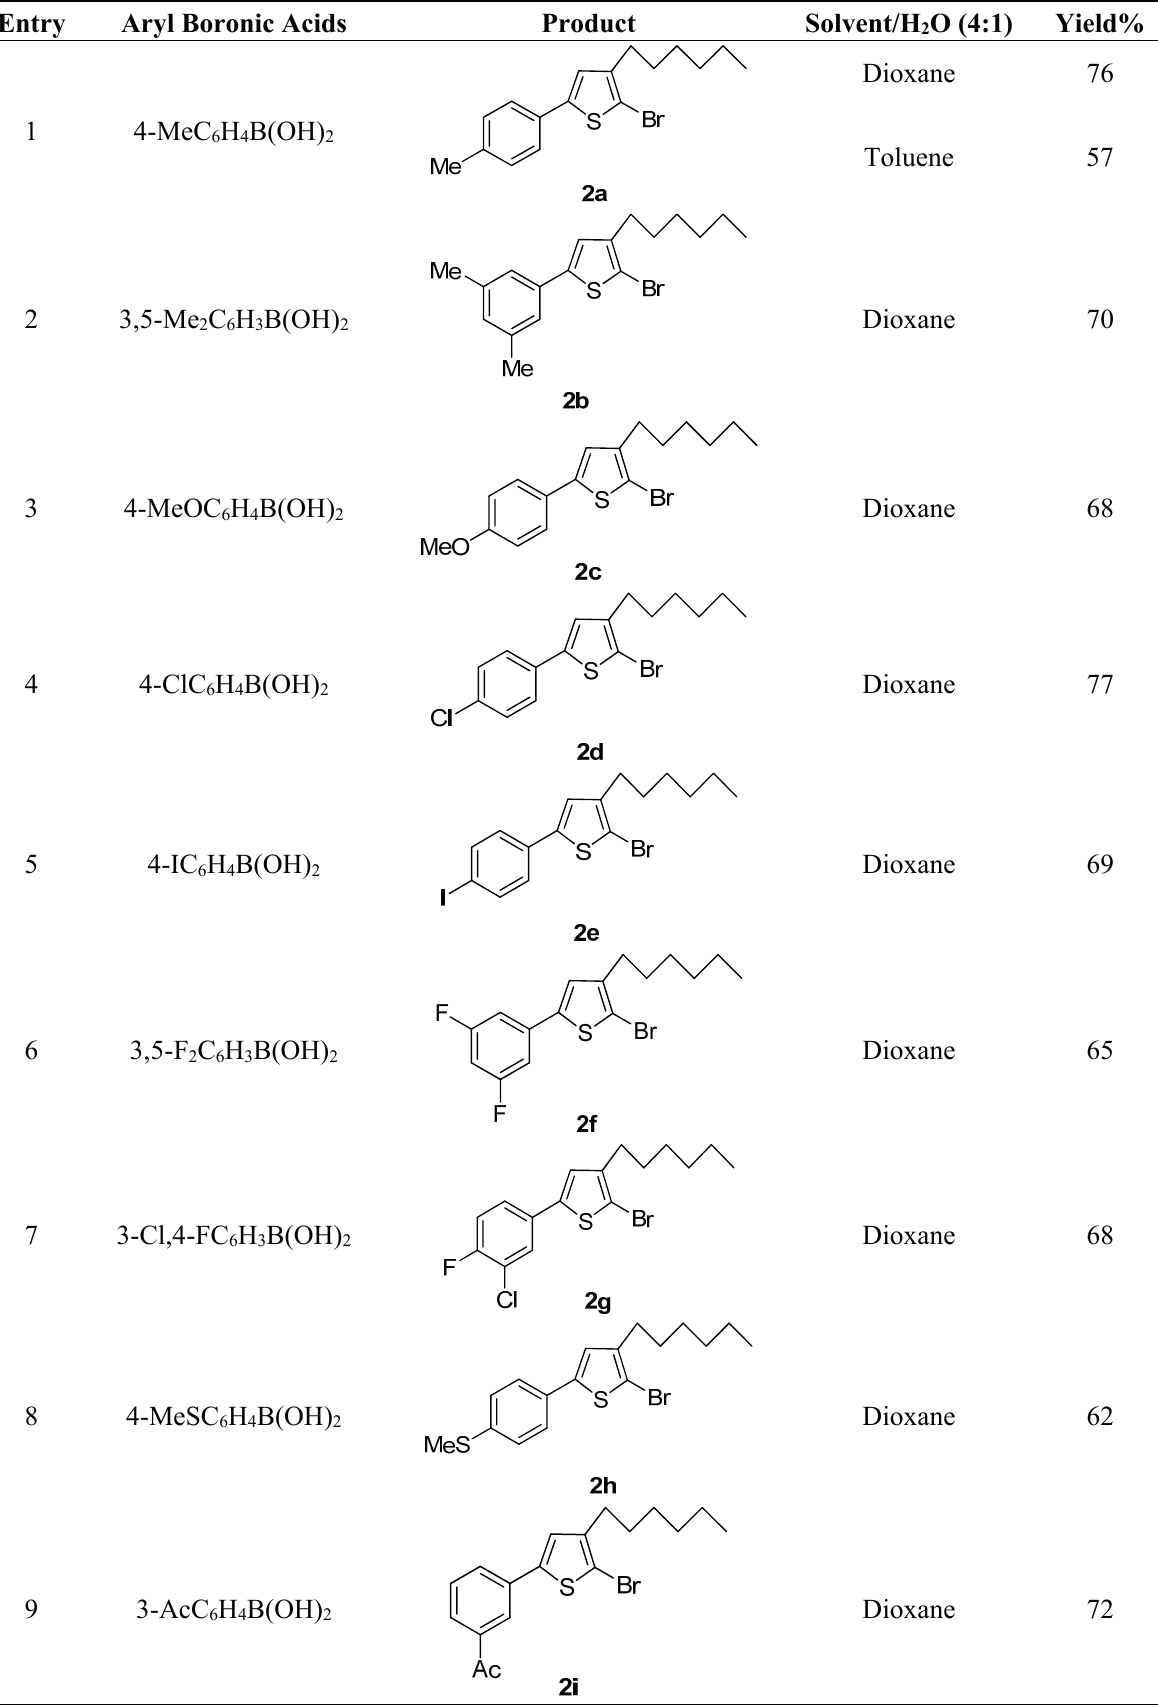
Table 1. Synthesis of 5-aryl-2-bromo-3-hexylthiophene ( 2a – i